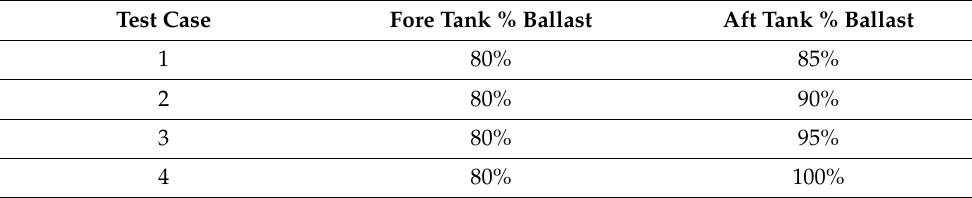
Table 5. SA: PB test conditions.